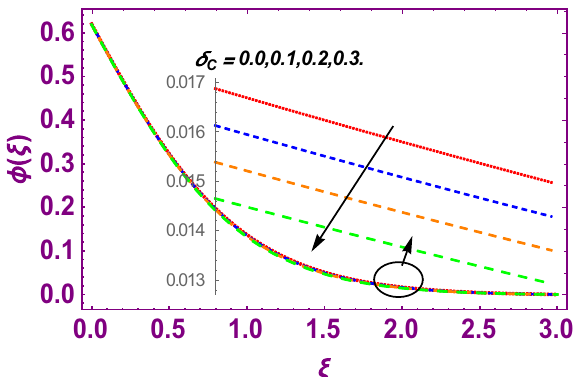
Figure 13. Effect of δ C on φ(ξ) .